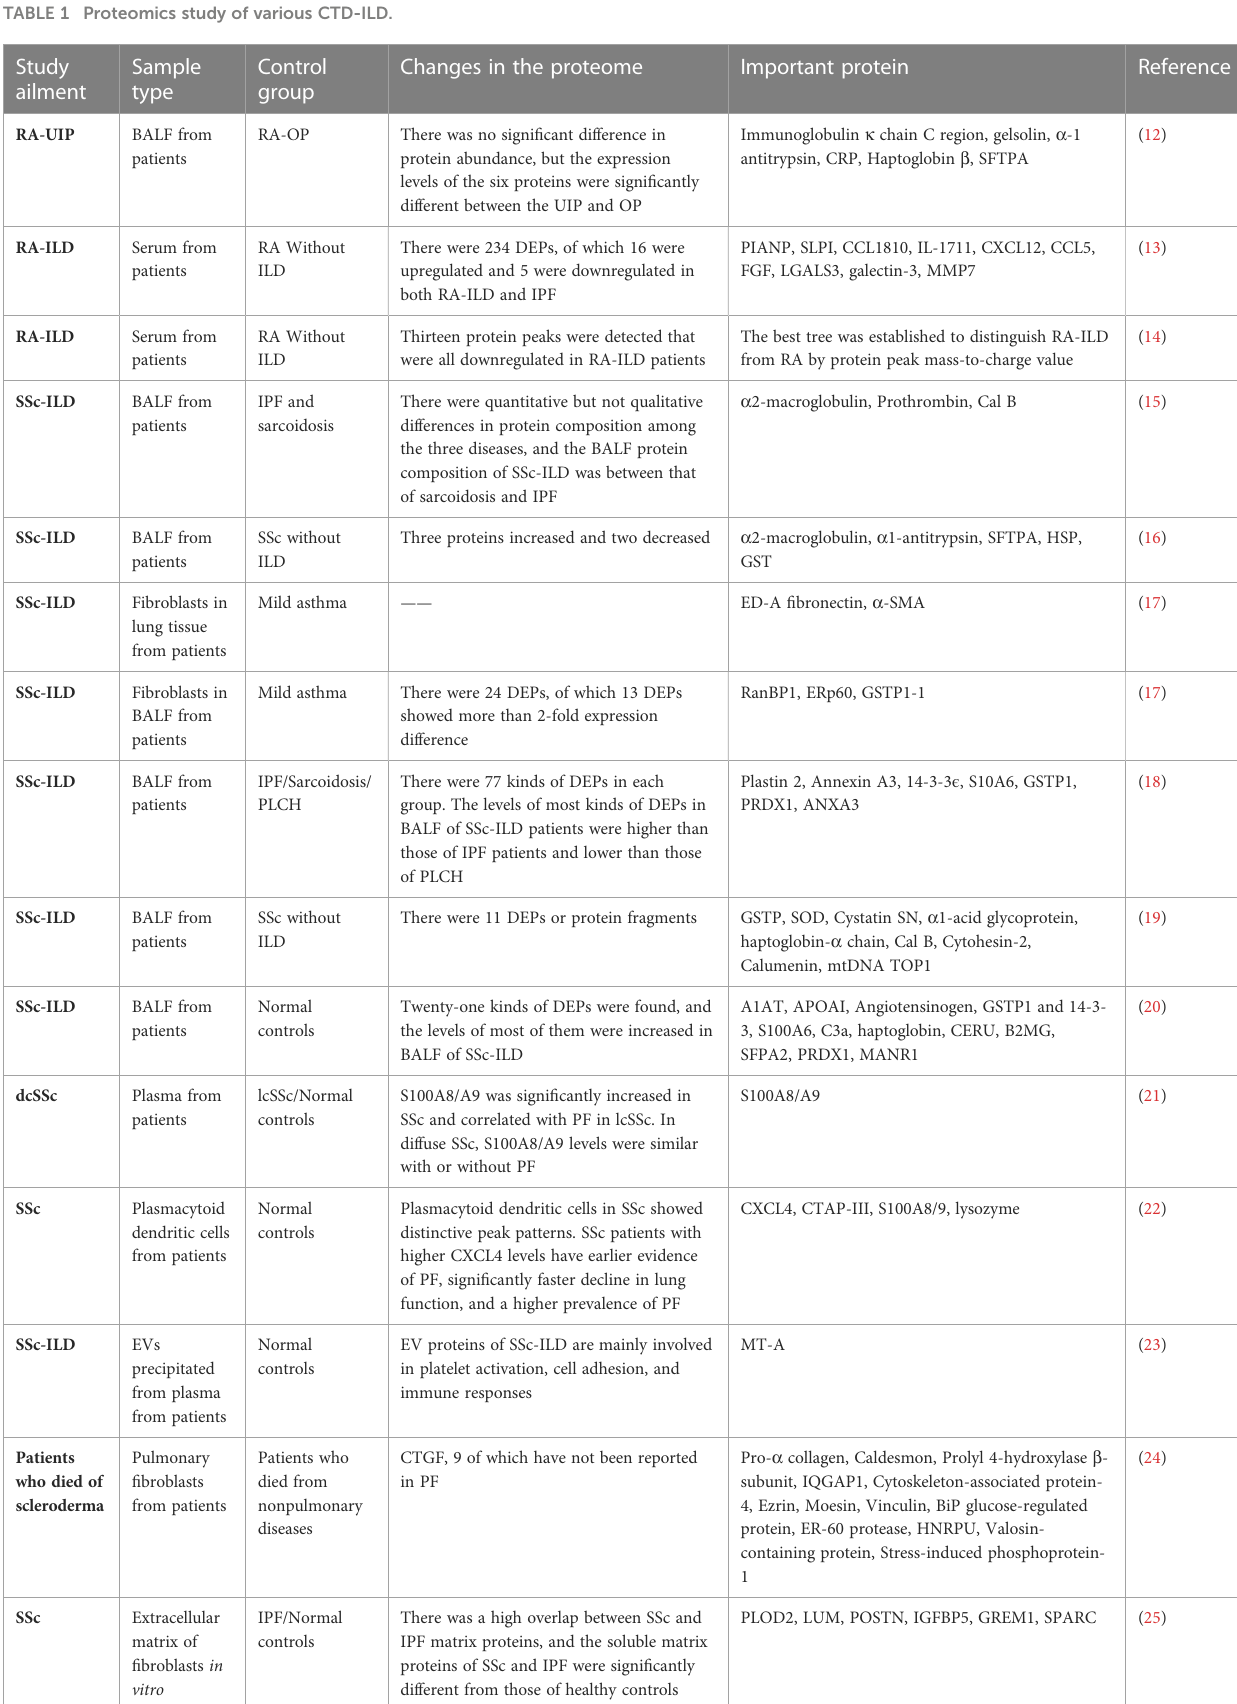
TABLE 1 Proteomics study of various